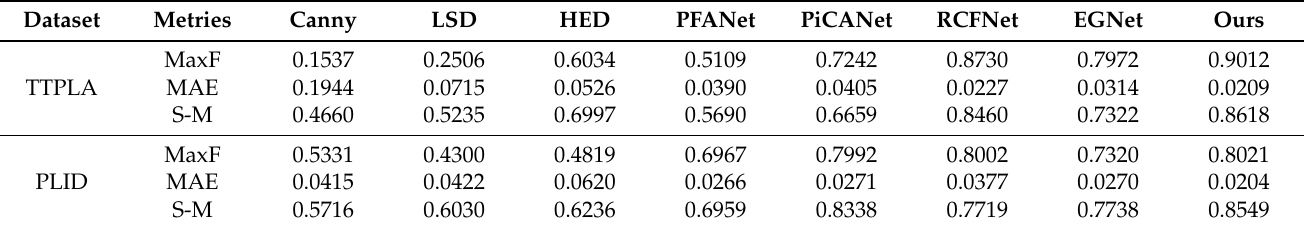
Table 2. Comparison of power line detection results with other methods on two datasets.